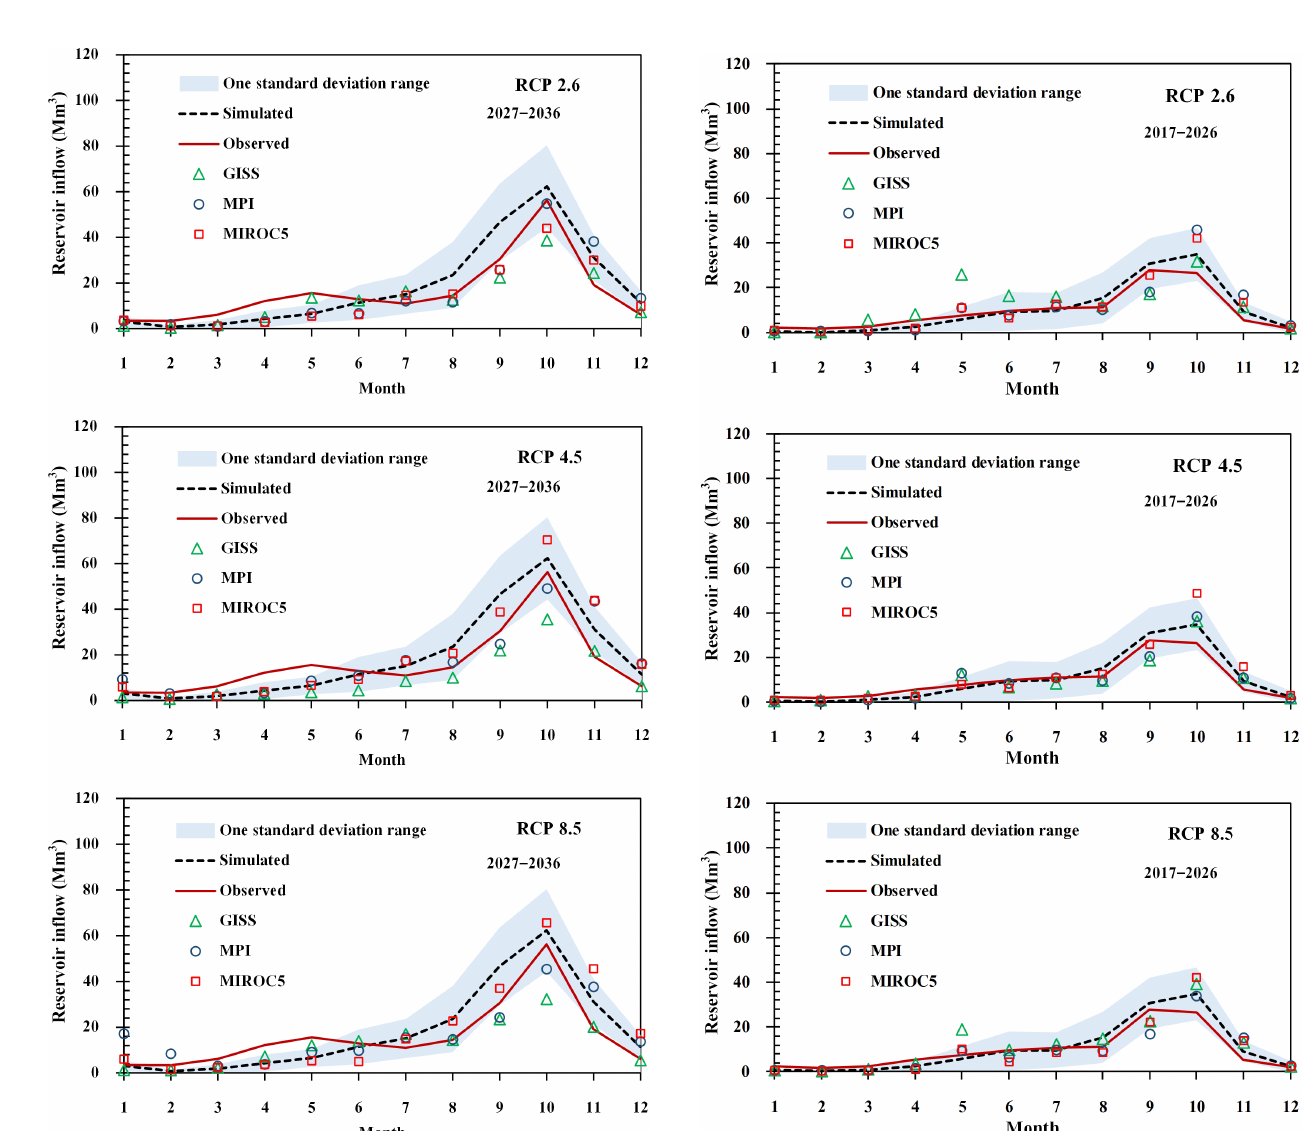
Figure 11. Projected mean monthly reservoir inflows under 3 sce- narios for the years 2027–2036 at Nong Pla Lai Resevoir.